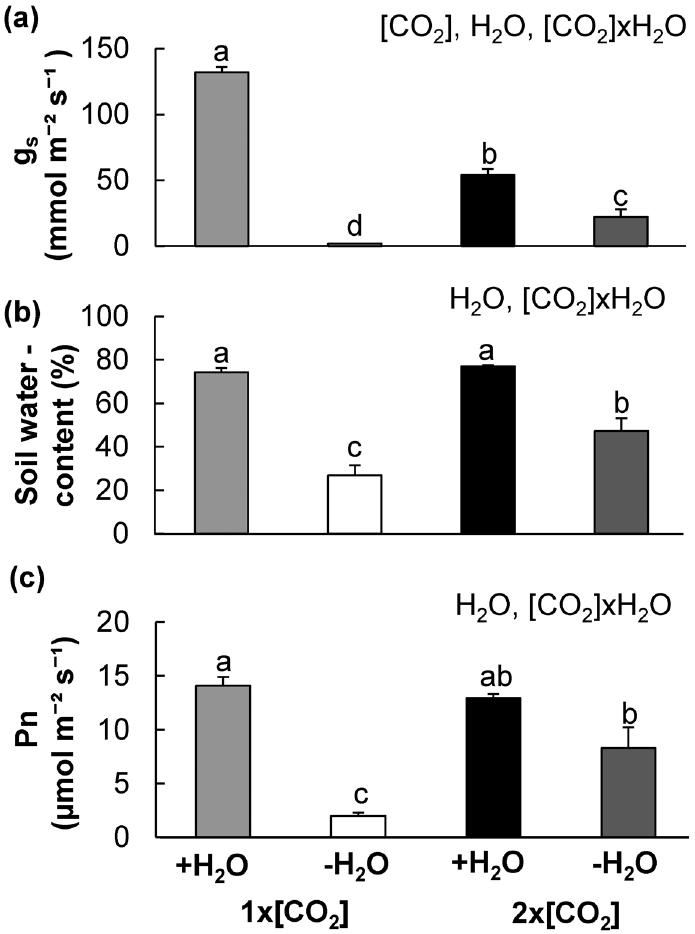
Fig 1. Drought treatment is representative of conditions in which maize plants benefit from elevated [CO 2 ] induced water conservation. Drought treatment was imposed on one month old maize by withholding water for five consecutive days. Gas exchange measurements were then taken from the fifth leaf of 1x[CO 2 ]